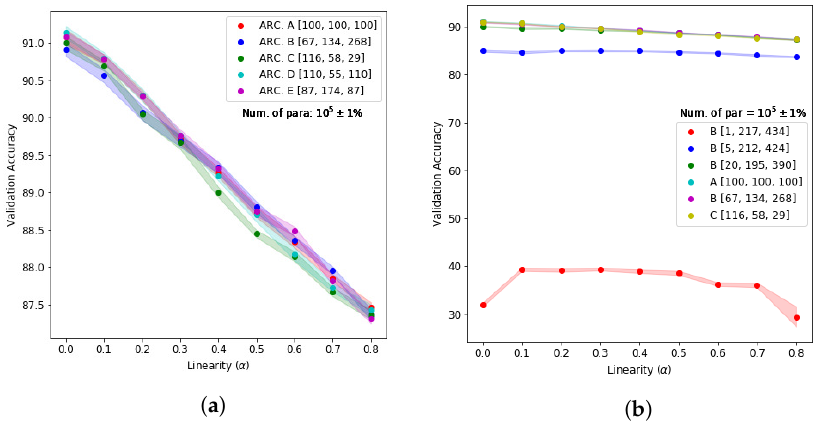
Figure A1. ( a ) The validation accuracy for different model architectures as a function of linearity factor ( α ) while maintaining the number of parameters fixed (10 5 ± 1%). ( b ) The average validation accuracy as a function of linearity factor ( α ) for the model architectures A, B and C for different number of parameters using 10,000 images from MNIST-digits data set. Shape B was tested for different widths of the first hidden layer while maintaining the number of parameters fixed (10 5 ± 1%).